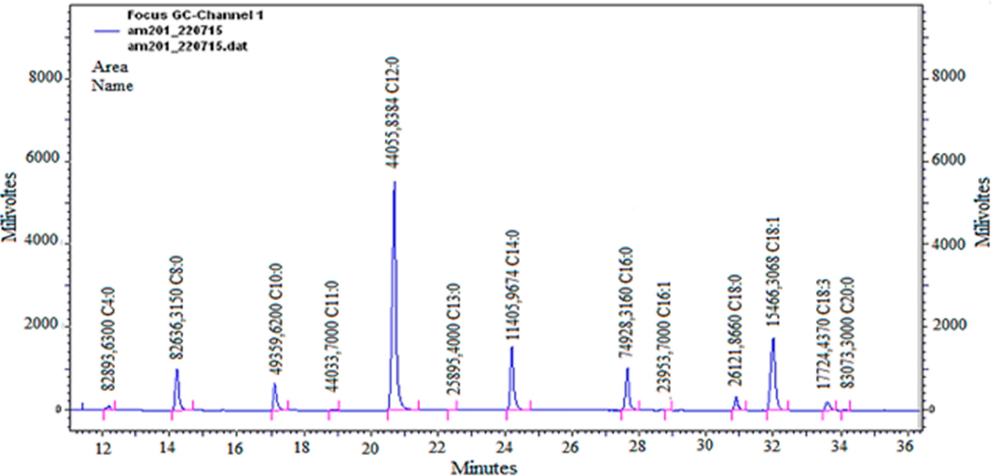
( B ) ( C ) ( D ) Figure 2. Main constituents identified in the fixed oil of the almond of A. heterophyllus and its structural representation: ( A ) lauric acid, ( B ) myristic acid, ( C ) palmitic acid, and ( D ) oleic acid. 3.2. Profile of Antibacterial Activity In the evaluation of the intrinsic antibacterial activity, it was verified that the fixed oil was effective only against the standard strain of S. aureus SA–ATCC 25923, with a MIC of 256 μ g/mL. For the other standard and MDR strains, the MIC was considered clinically irrelevant ( ≥ 1024 μ g/mL) (Table 3). The lowest MIC verified for S. aureus corroborates other works that mention the antibacterial property of fixed oils against Gram-positive strains [3,8]. The main constituent of jackfruit oil, lauric acid (Figure 2), has been reported to have bacterial activity, especially against Gram-positive species such as S. aureus [18]. On the other hand, Gram-negative bacteria are considered intrinsically more resistant to antibiotics due to the structure of their cell wall, which has an outer membrane with lipopolysaccharides in its constitution, reducing permeability [19].